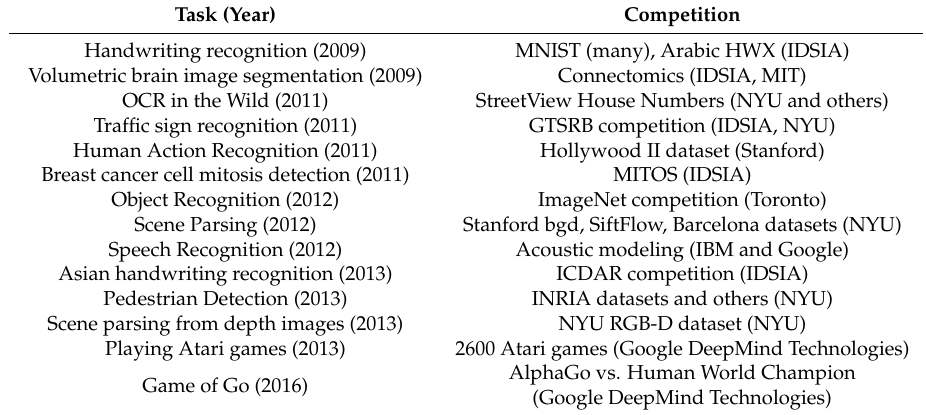
Table 1. Deep Artificial Neural Networks Achievements. Adapted from a slide developed by Yann Lecun, Facebook and NYU [32].